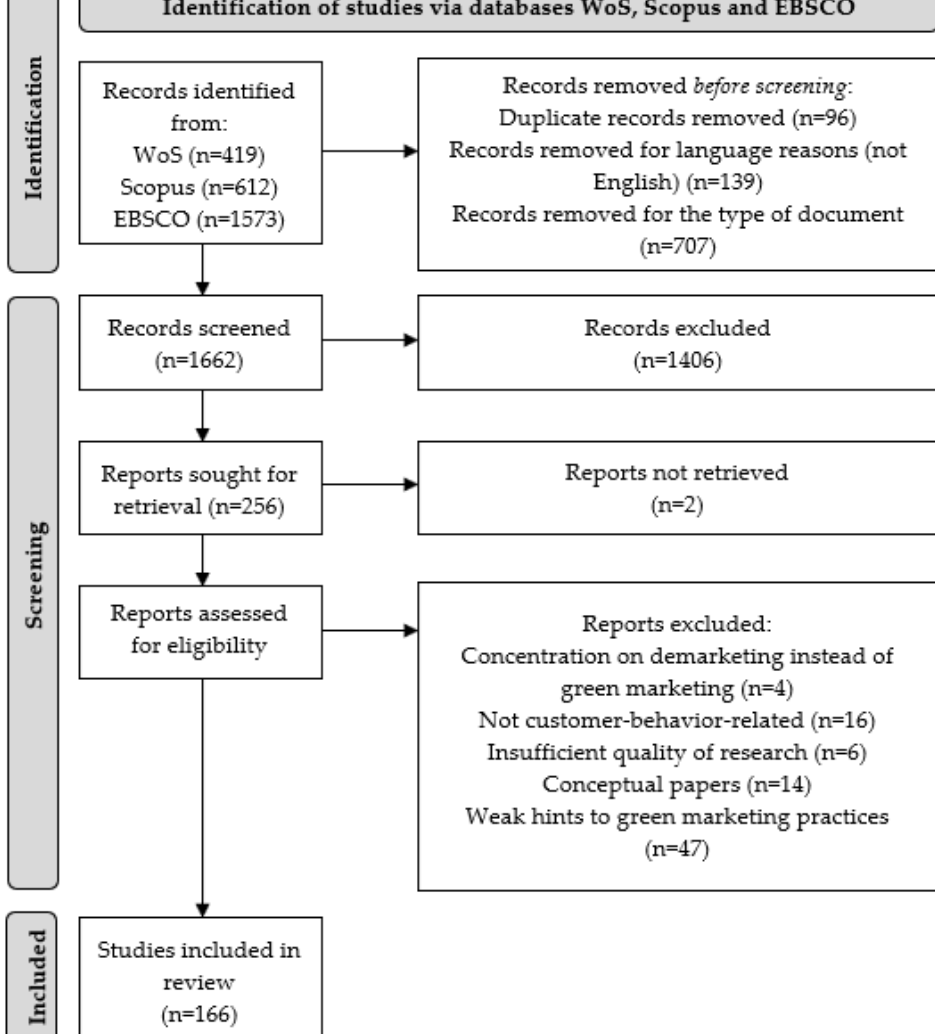
Figure 1. Flowchart of the literature-selection process based on the PRISMA approach.